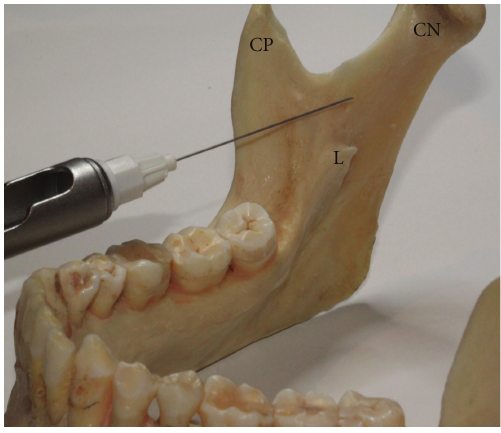
Figure 6: Photograph of the mandibular ramus from a medial view showing the needle tip positioning required for the Akinosi closed mouth mandibular nerve block technique. Note that the needle should not contact bone during needle insertion. The needle tip slips along the medial aspect of the ramus to its intended target area, the loose areolar tissue within the superior reach of the pterygomadibular space (CN: condylar neck, CP: coronoid process, L: